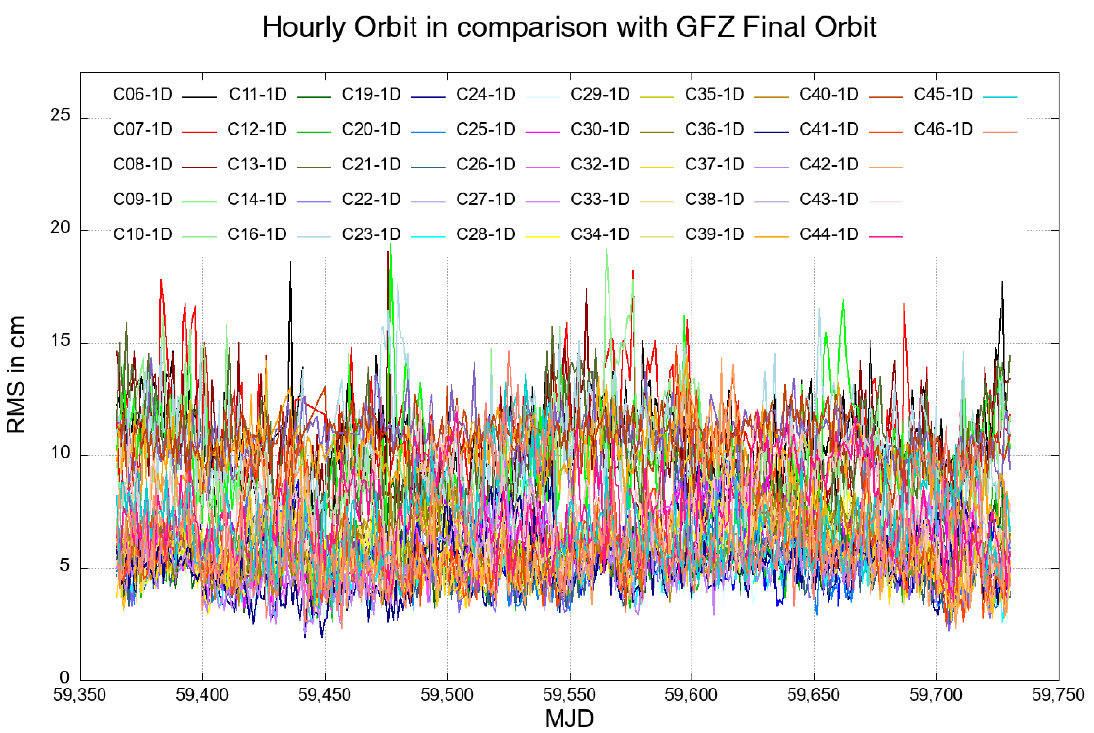
Figure 9. Time series in 1-D of GPS satellites compared with GFZ final orbit.